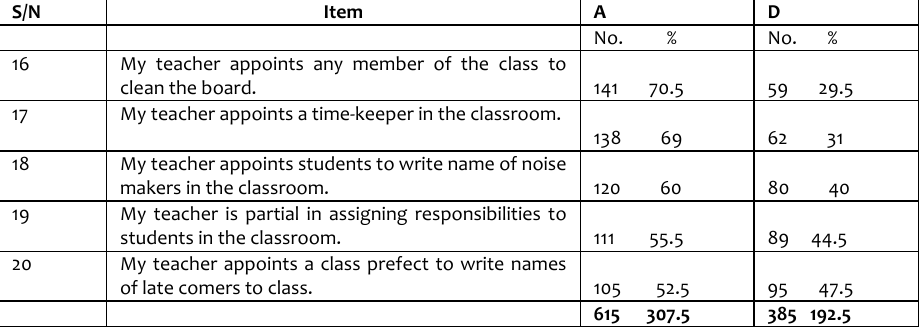
Figure 4: Percentage Presentation of data for question 4